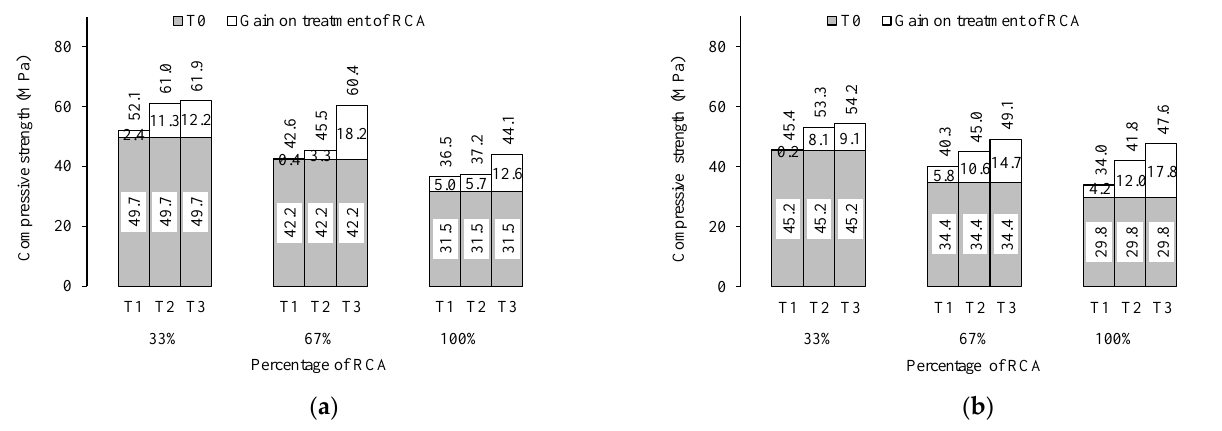
Figure 11. Gain in compressive strength because of the treatment of RCA by different methods (T1, T2, and T3) for: ( a ) 10-mm aggregate; and ( b ) 20-mm aggregate.